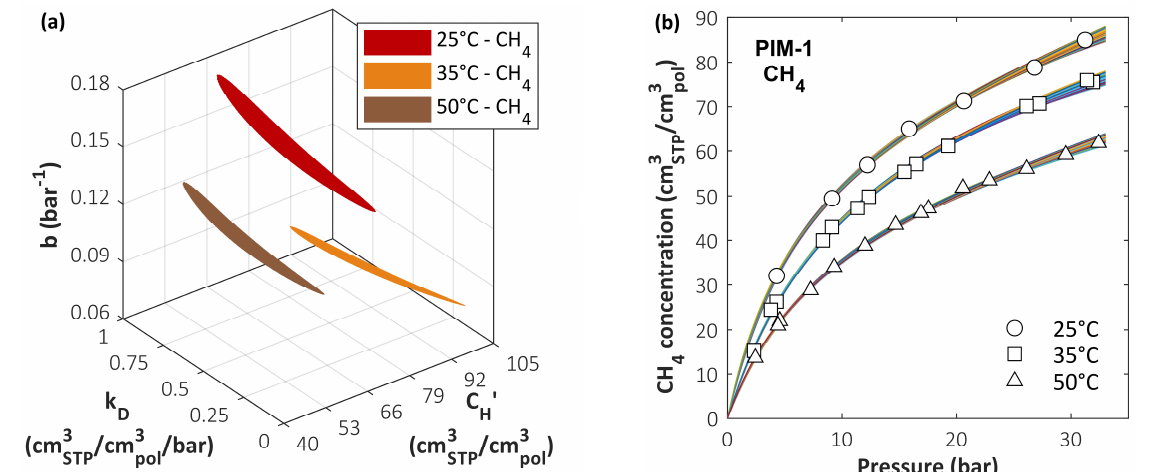
Figure 8. ( a ) Surfaces enclosing the range where DMS parameter sets yield a relative standard error RSE < RSE max in the prediction of CH 4 sorption in PIM-1 at three different temperatures [191]; ( b ) CH 4 sorption isotherms in PIM-1 at 25, 35, and 50 ◦ C (experimental data from [39]) calculated with all the parameter sets enclosed by the corresponding colored regions in the plot on the left [191].